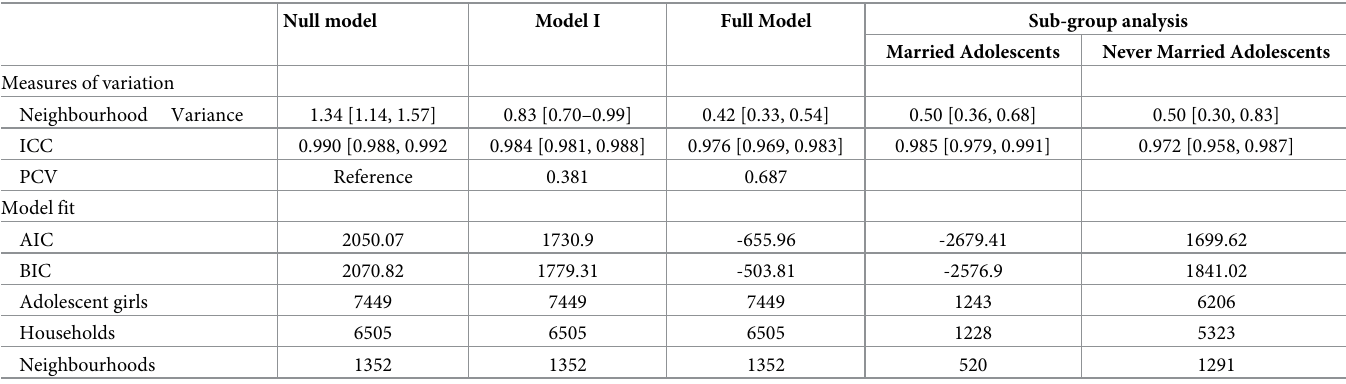
Table 4. Summary of random effect and model